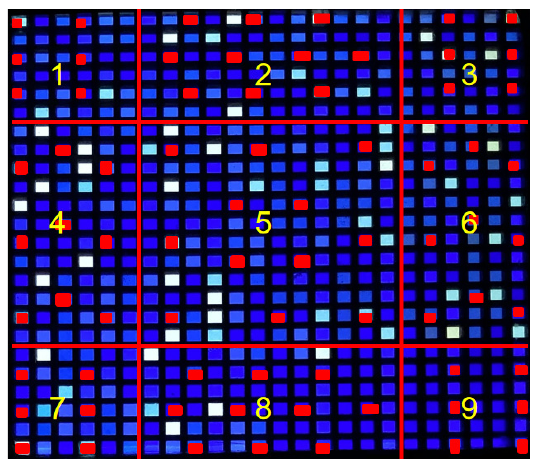
Figure 10. Experimental partition map.